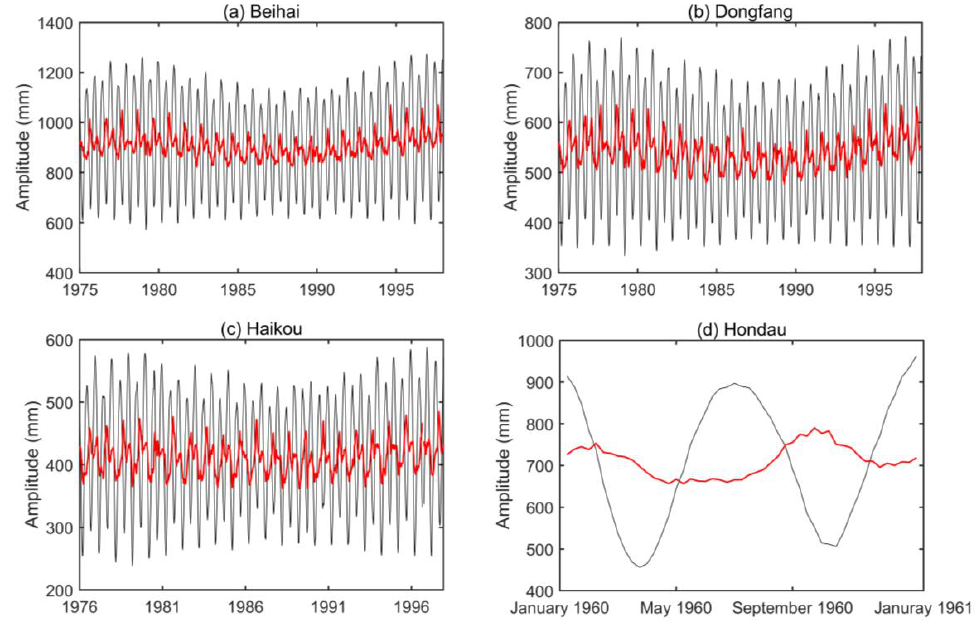
Figure A1. Estimated K 1 amplitudes (unit: mm) with (red lines) and without inference using the equilibrium value (black lines) in the Gulf of Tonkin. ( a ) Beihai ( b ) Dongfang ( c ) Haikou ( d ) Hondau.